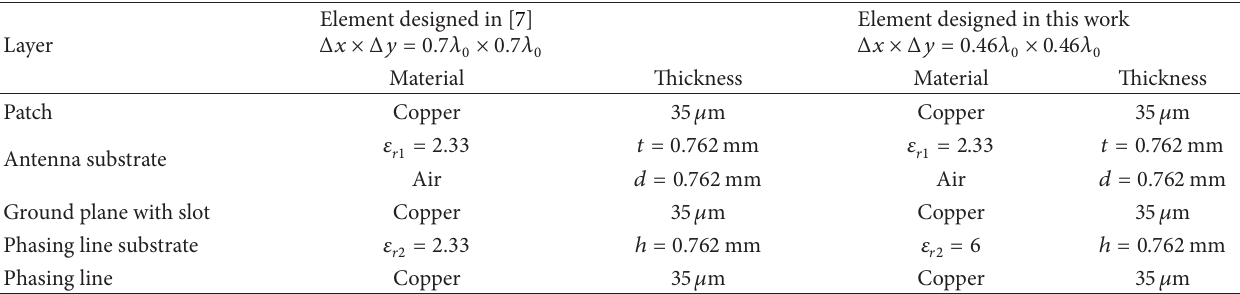
Figure 5: Phase curves versus diode capacitance for different line lengths: (a) 𝐿 V = 4.2 mm and 𝐿 𝑠 ranging from 2mm up to 5.4 mm; (b) 𝐿 V ranging from 4.2 mm up to 4.4 mm for some fixed values of 𝐿 𝑠 . Table 1: Element